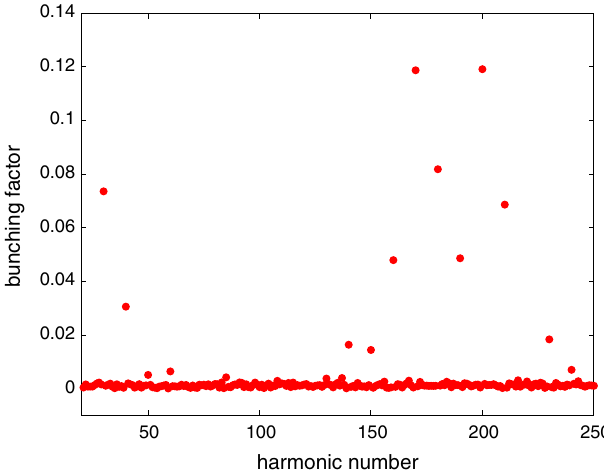
FIG. 4. (Color) Bunching factors for various compressed har- monic numbers Cn .